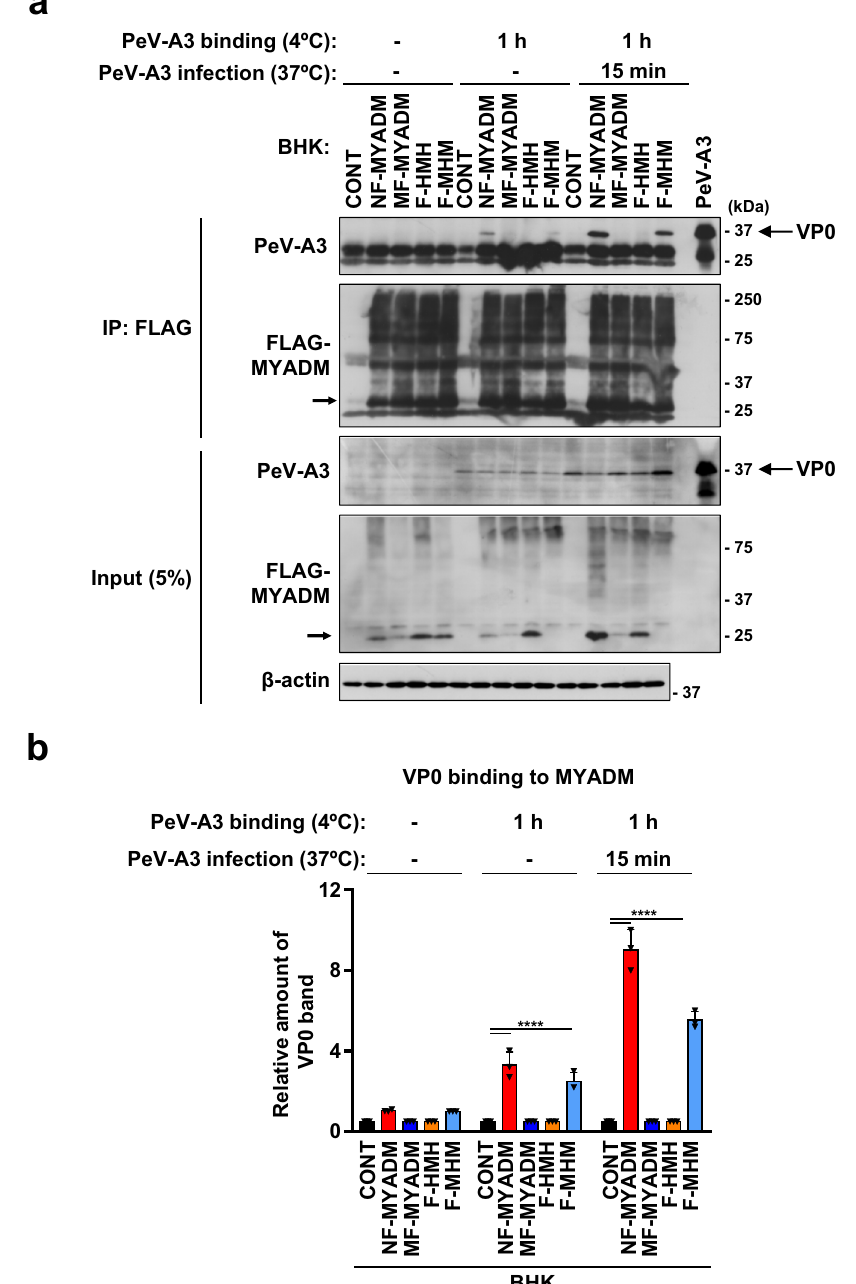
Fig. 7|PeV-A3capsidproteinsinteractwiththefourthextracellulardomainof humanMYADM.a,b TheindicatedcellswereincubatedwithconcentratedPeV-A3 (A308/99) at 4°C for 1h, washed with PBS, and then incubated at 37°C for 15min. Cells were lysed with NP-40 lysis buffer and cell lysates were immunoprecipitated withanti-FLAGantibodies.Immunoprecipitates(IP)andpre-IPlysates(INPUT)were characterized by Western blotting with the indicated antibodies. The intensity of